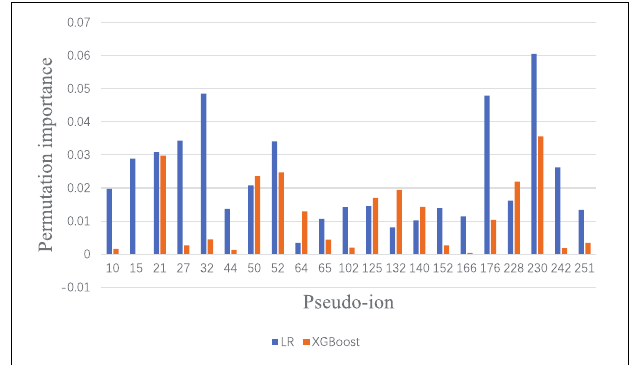
FIGURE 4 | Significant permutation importance comparison between LR and XGBoost under Lowest Power set ensemble.